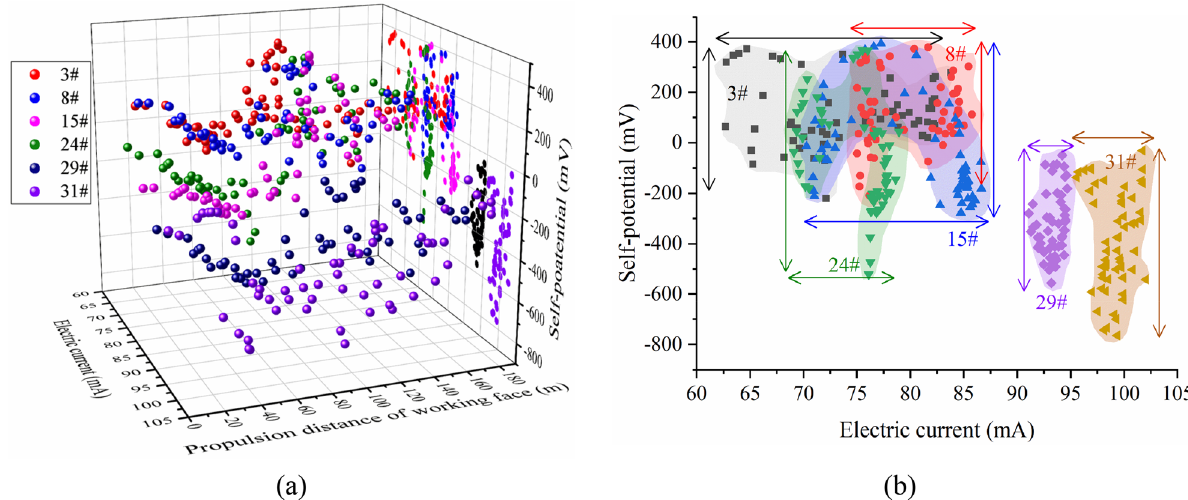
Figure 11. Scatter plot of geoelectric field data during mining. ( a ) 3D scatter plot. ( b ) 2D scatter